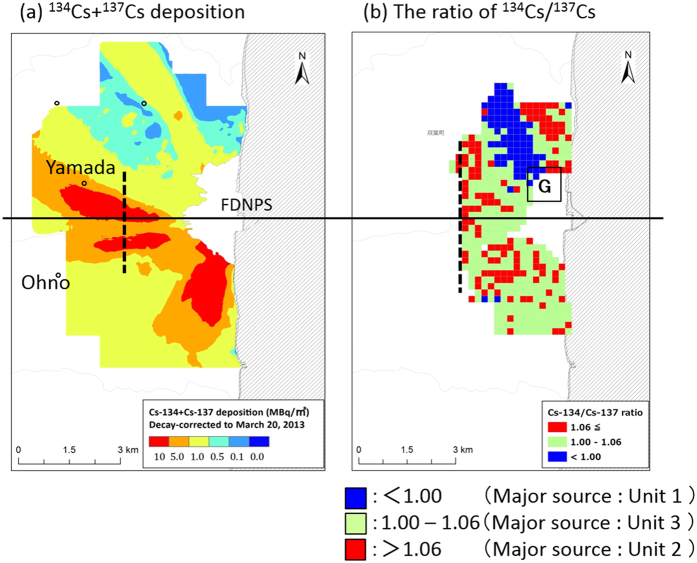
Autonomous unmanned helicopter (AUH) survey; spatial maps of (a) 134Cs+137Cs deposition over the 5-km area of FDNPS27 and (b) the 134Cs/137Cs ratio over the 3-km area. The spatial distribution maps are created using ArcGIS version 10.3 (http://www.esri.com/) with administrative boundary data and background map by The Geospatial Information Authority of Japan (http://maps.gsi.go.jp/).